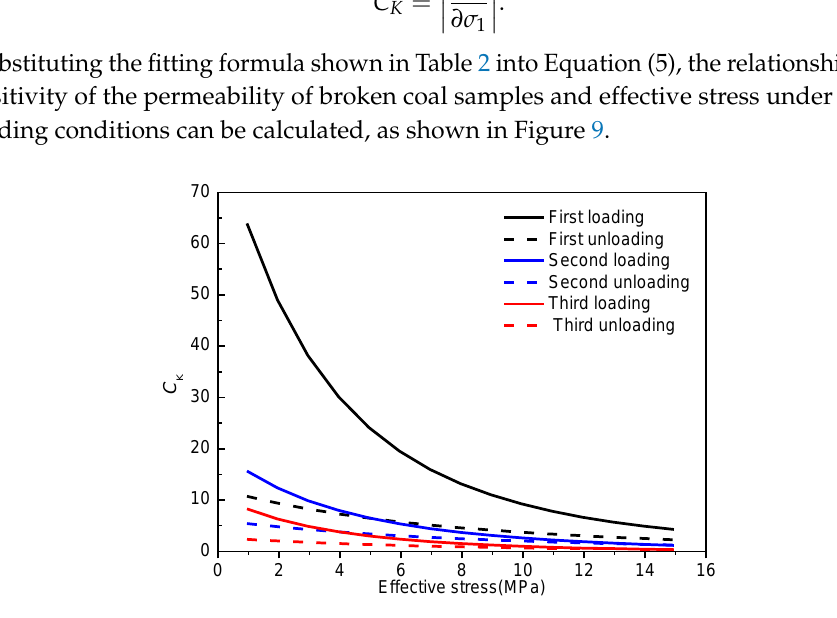
Figure 9. Stress sensitivity coefficients of permeability of broken coal samples under cyclic loading and unloading conditions.